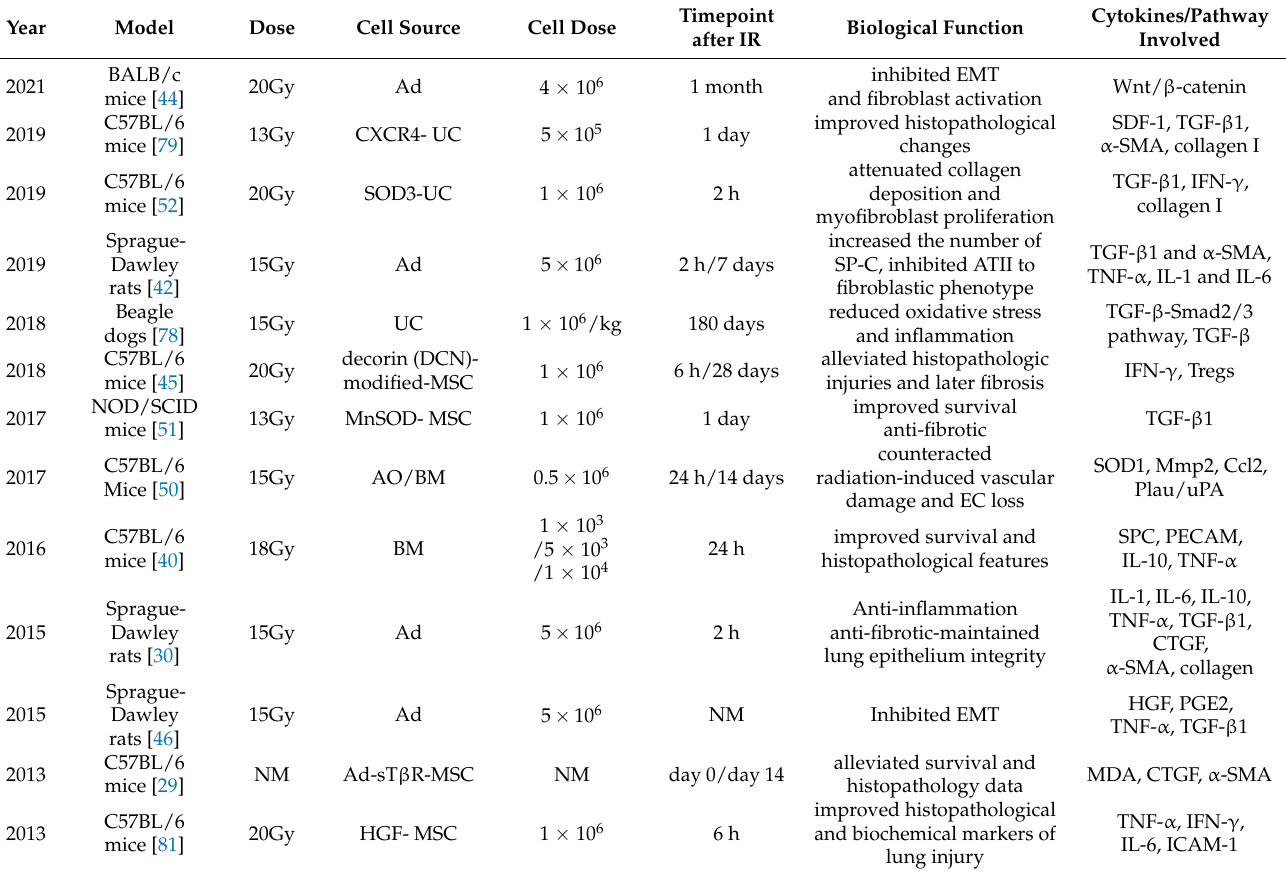
Table 1. Summary of important preclinical studies examining the efficacy of MSC in